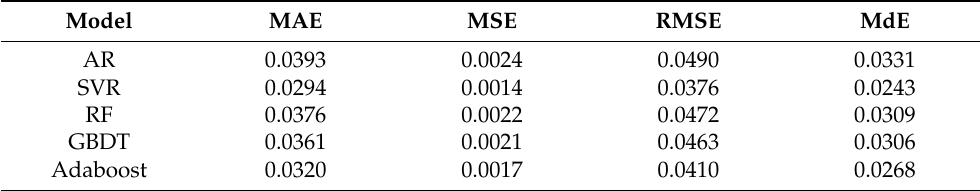
Table 3. Predicting results of sentiment score based on different models.